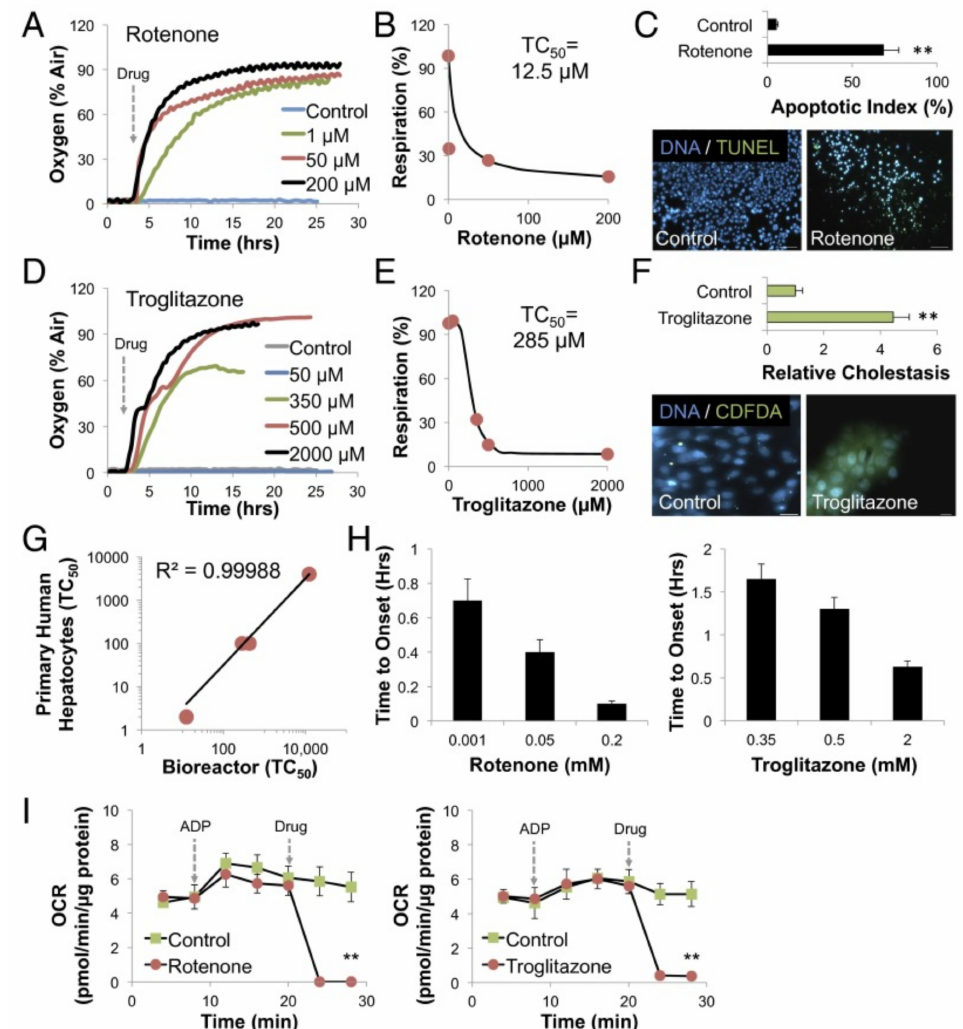
Figure 4. Oxygen sensors for a liver-on-a-chip system, reproduced with permission from Ref. [134]. ( A ) Increasing concentrations of rotenone are administered to HepG2/C3A cells as time progresses in relation to oxygen uptake. ( B ) After 12 h, TC 50 was found to be 12.5 µ M, indicating dose dependence of rotenone. ( C ) Following 24 h of exposure to 200 µ M rotenone ( p < 0.001, n = 5), the researchers found that there was a 14-fold increase in apoptosis, found by TUNEL staining, and unlabeled cell death, indicating necrosis. ( D ) Increasing concentrations of troglitazone are administered to HepG2/C3A cells as time progresses in relation to oxygen uptake. ( E ) After 24 h, TC 50 was found to be 285 µ M, indicating dose dependence of r troglitazone. ( F ) Following 24 h of exposure to 200 µ M troglitazone ( p < 0.001, n = 5), the researchers found that there was a 4.5-fold increase in the intracellular buildup of bile acids (cholestasis), found by CDFDA staining. ( G ) Curve graph with an R 2 = 0.99 correlation for acetaminophen, amiodarone, troglitazone, and rotenone, displaying TC 50 values of primary human hepatocytes to their bioreactor. ( H ) The picture on the left shows mitochondrial damage due to dose dependence for rotenone concerning time, while the picture on the right shows the dose dependence of troglitazone. These graphs use the unit of time in minutes instead of hours when describing the exposure of the drugs. ( I ) Shows the relationship of OCR as time progresses. The process included 30 min of isolated mitochondria, then ADP administration, then administration of 50 µ M rotenone, shown on the picture on the left. On the right is troglitazone. Through a t- test p < 0.01, results showed that there was an instant decrease of OCR ( p < 0.001, n = 3), and cytosolic enzyme activation of the drugs were not needed. ** p < 0.01 by students’s